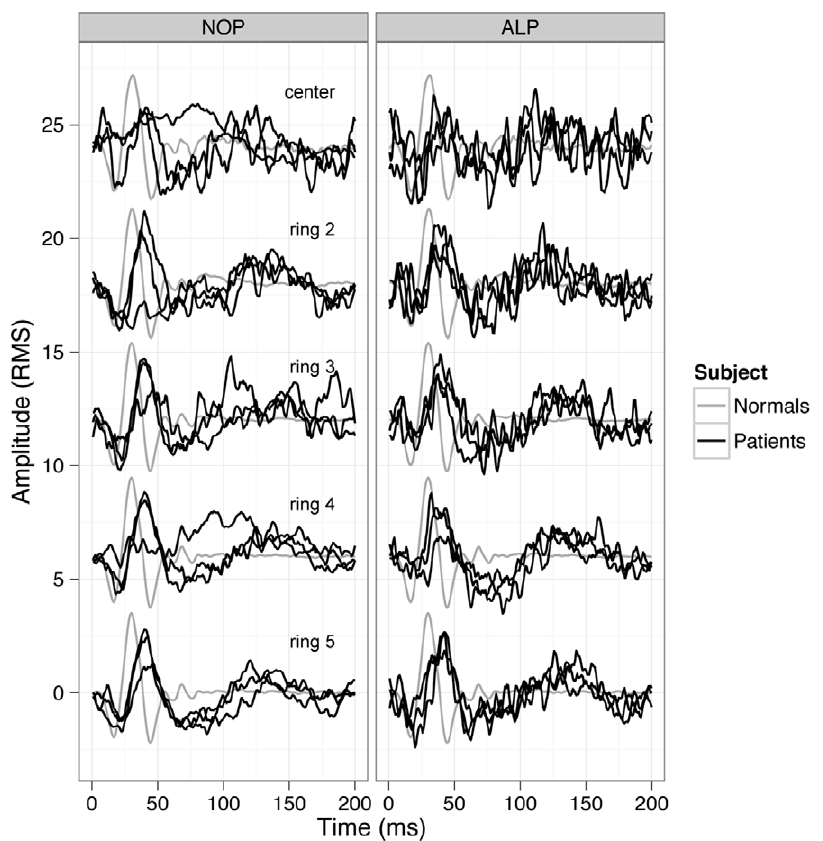
Figure 11. MfERG results. Individual mfERG response waveforms for the subjects of each group (NOP group on the left, ALP group on the right) compared to normal subjects waveforms (black curves represent the responses of the patients, grey curves show normal responses). Responses of patients are reduced and delayed in both groups, more pronounced in the central rings. Interestingly, in the ALP group the central 2 rings tend to show more preserved responses. This could be in relation with the slightly better VA of the ALP group.